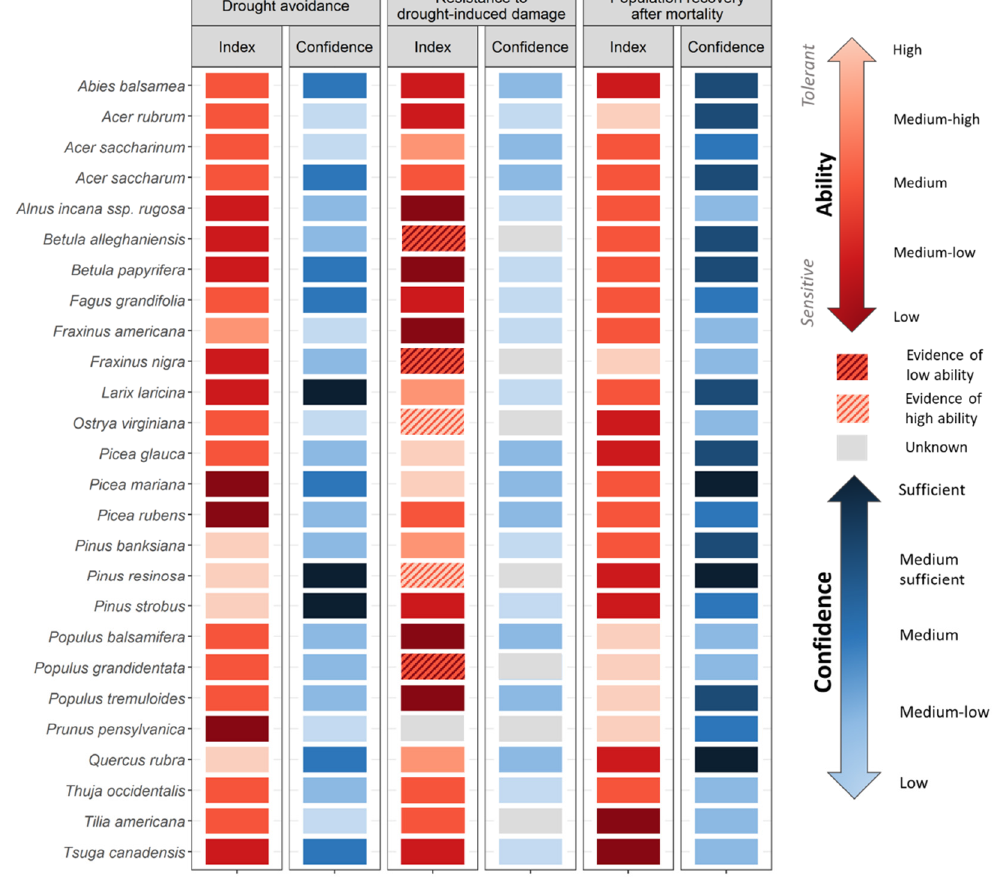
Figure 2. Tree species ability to cope with drought for three main strategies: Drought avoidance , Resistance to drought-induced damage , Population recovery after drought . Each index ranks the relative ability (from low / sensitive to high / tolerant, reds) of tree species for a specific strategy (see Scheme 1 for which mechanisms / traits were considered). Species for which information was not available were attributed an intermediate value, depending if there was evidence of tolerance or not (diagonal hatched stripes: dark red hatched—evidence of low ability; light red hatched—evidence of high ability). Confidence associated with available data is also presented, as ranked from low to sufficient (blues). Species for which no data was available were considered as Unknown (grey). For more details on definitions and ranking, see Table S1.